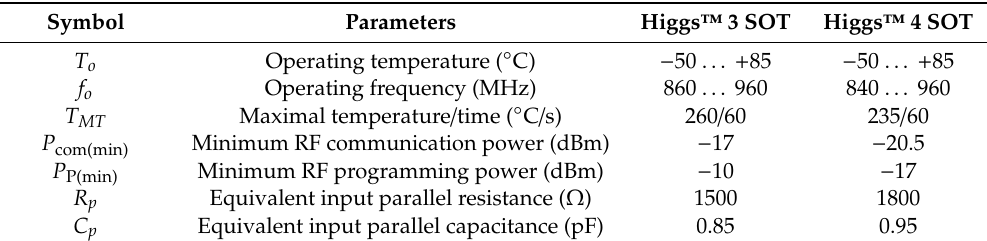
Table 1. Parameters of integrated circuits for UHF RFID tags in [27]